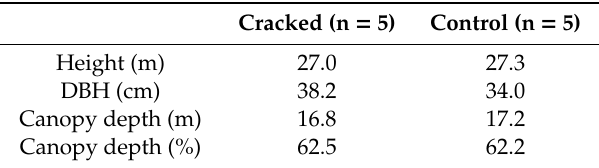
Table 1. Height, diameter at breast height (DBH), canopy depth (actual and as a % of tree height) of cracked and control model